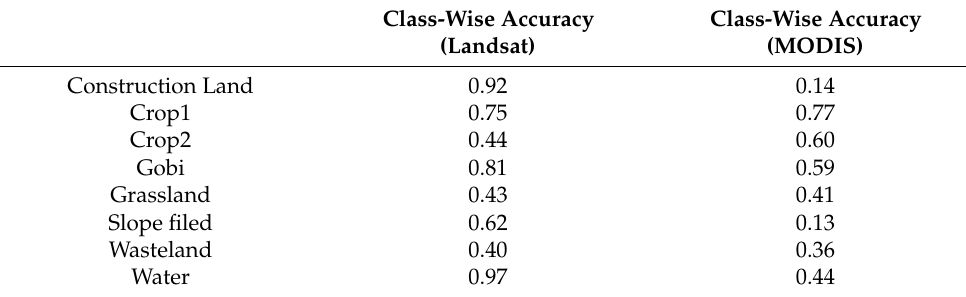
Figure 9. Single-source classification results of ( a ) MODIS and ( b ) Landsat data. Table 2. Class-wise classification accuracy obtained for Landsat and MODIS data.